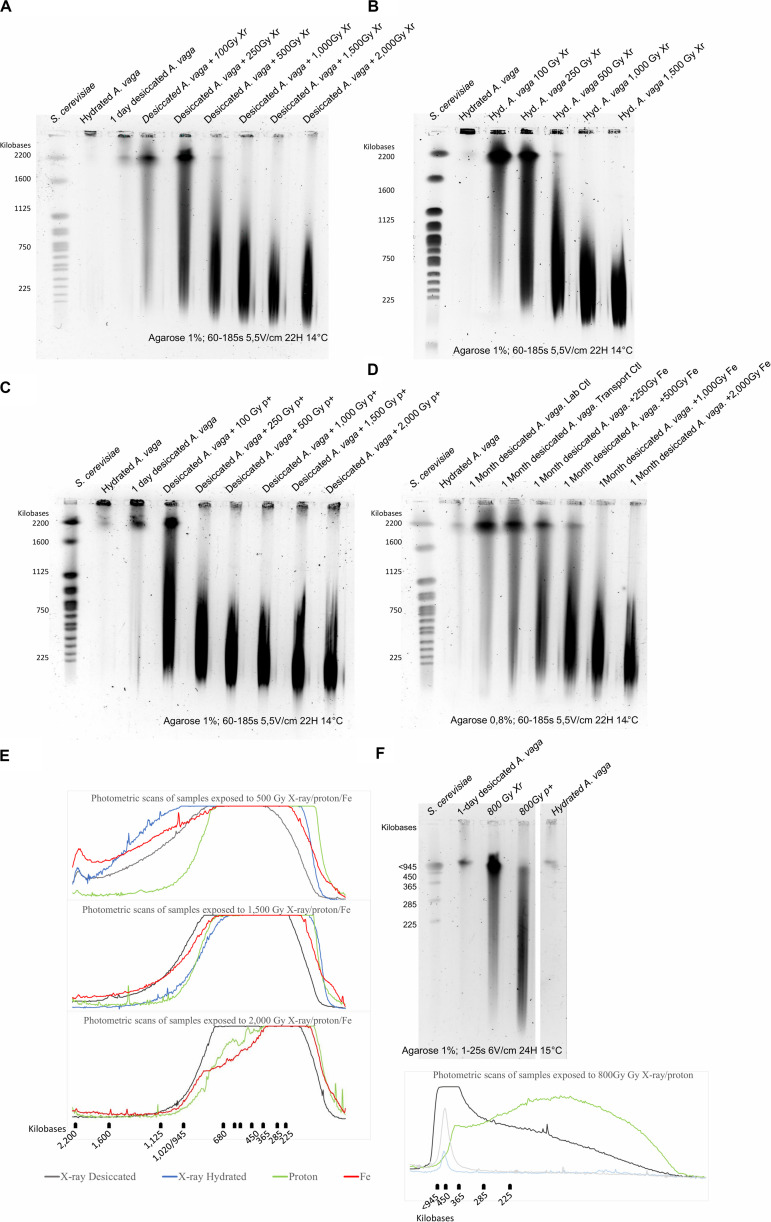
Loss of genomic integrity in A. vaga individuals exposed to increasing doses of X-ray (A,B), Protons 4 MeV (C) and Fe 1 GeV (D); Comparative analysis of photometric scans from samples exposed to 500; 1,500 and 2,000 Gy (E); Comparative analysis of 1-day desiccated A. vaga individuals exposed to 800 Gy of X-ray and protons 4 MeV using short fragments run parameters (15–291 kbp) (F). For X-ray exposure, rotifers were irradiated after 1 day of desiccation (A) or irradiated in hydrated state (B). Rotifers were desiccated 1 day before exposure to Protons 4 MeV (C). However, samples exposed to Fe were desiccated 1 month (D). The first lane on the pulsed-field gel electrophoresis corresponds to the karyotype of Saccharomyces cerevisiae. Second lanes correspond to the control (1,000 hydrated A.vaga individuals). Third lanes of (A,C) correspond to DNA fragmentation induced by 1-day desiccation on 1,000 individuals. Other lanes correspond to 1,000 desiccated (A,C,D) or hydrated individuals (B) after exposition to 100, 250, 500, 1,000, 1,500 and 2,000 Gy (in exception of (B) where maximum dose was 1.500 Gy). For the comparative analysis focusing on short DNA fragments dose of 800 Gy of respectively X-ray and protons was used (Lane 3 and 4). Hydrated control was in lane 5. 1-day desiccated A. vaga individuals was at lane 2. The run parameters are documented under each gel. Photometric scans were generated using ImageJ (see “Materials and Methods” section). Top flat lines from photometric scans correspond to saturated levels.